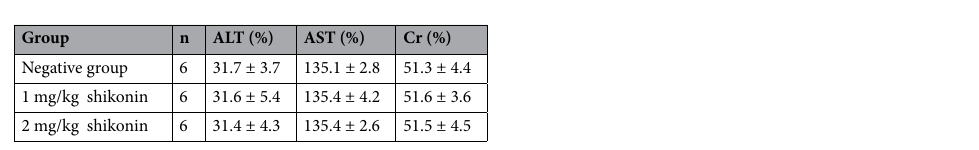
Figure 5. Effects of shikonin on toe swelling and hepatorenal toxicity in AA rats. ( A ) Symptoms were assessed in AA rats 14 days after immunization. ( B ) The left hind paws of rats from different groups on 32 days. ( C ) The arthritic paw swelled from days 7 to 32 in the shikonin (1 and 2 mg/kg) groups and the MTX (0.5 mg/kg) group. ( D ) Lactic acid changes were detected by using a lactic acid kit in vivo . (Table 1) The effects of shikonin on liver and kidney toxicity in rats. Data are expressed as the mean ± standard deviation (SD), n = 6, # p < 0.05, ## p < 0.01 vs the control group; *p < 0.05, **p < 0.01 vs the AA group. Low dose: 1 mg/kg/day, high dose: 2 mg/kg/day. Lateral toe volume was measured every 3 days.